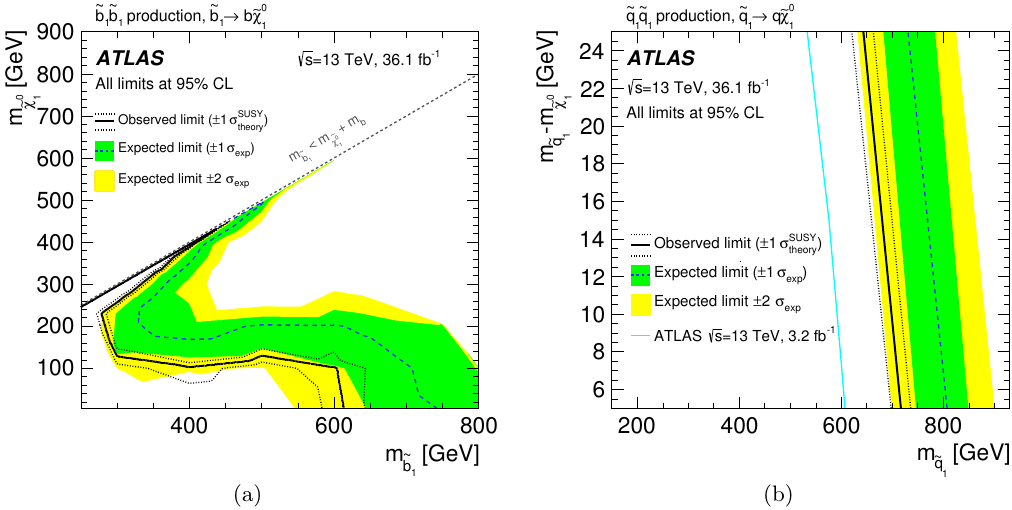
Figure 9 . Excluded regions at the 95% CL in the (~ t 1 ; ~ (cid:31) 0 ~ t 0 (B = 100%) and (b) the decay channel ~ t 1 ! b + ff 0 + ~ (cid:31) 0 1 ! c + ~ (cid:31) 1 around the observed limits indicate the range of observed limits corresponding to (cid:6) 1 (cid:27) variations of the NLO SUSY cross-section predictions. The bands around the expected limits indicate the expected (cid:6) 1 (cid:27) and (cid:6) 2 (cid:27) ranges of limits in the absence of a signal. The results from this analysis are compared to previous results from the ATLAS Collaboration at